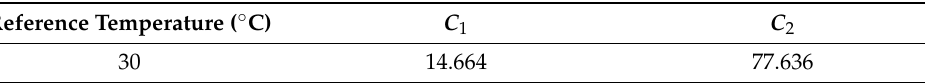
Figure 11. Migration coefficient fitting curve.